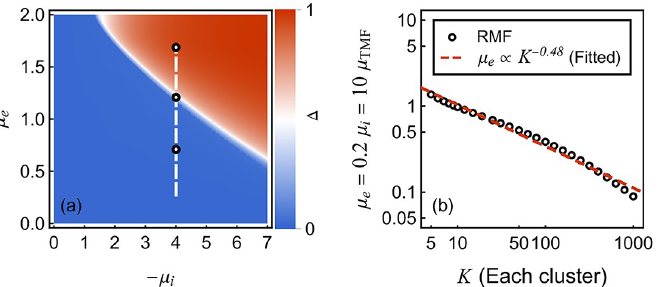
Fig 13. Phase transition. Panel (a): In this density plot of bifurcation observable Δ , μ e and μ i are varied. The white dashed line represents the parameters ( μ , − μ ) used in Fig 11. The black circles correspond to the parameters for the e i simulations shown in Fig 10b, 10c and 10d. Panel (b) is the log-log plot of the value of μ at the onset of bifurcation e varying the size of the network, determined by thresholding Δ = 0.01 in the RMF calculation (black circles). The red dashed line is the linear fitting in the log-log scale, which has a slope of − 0.48. Parameters: h = 1 Hz, a = ln(100)/20 � 0.23, τ = 10